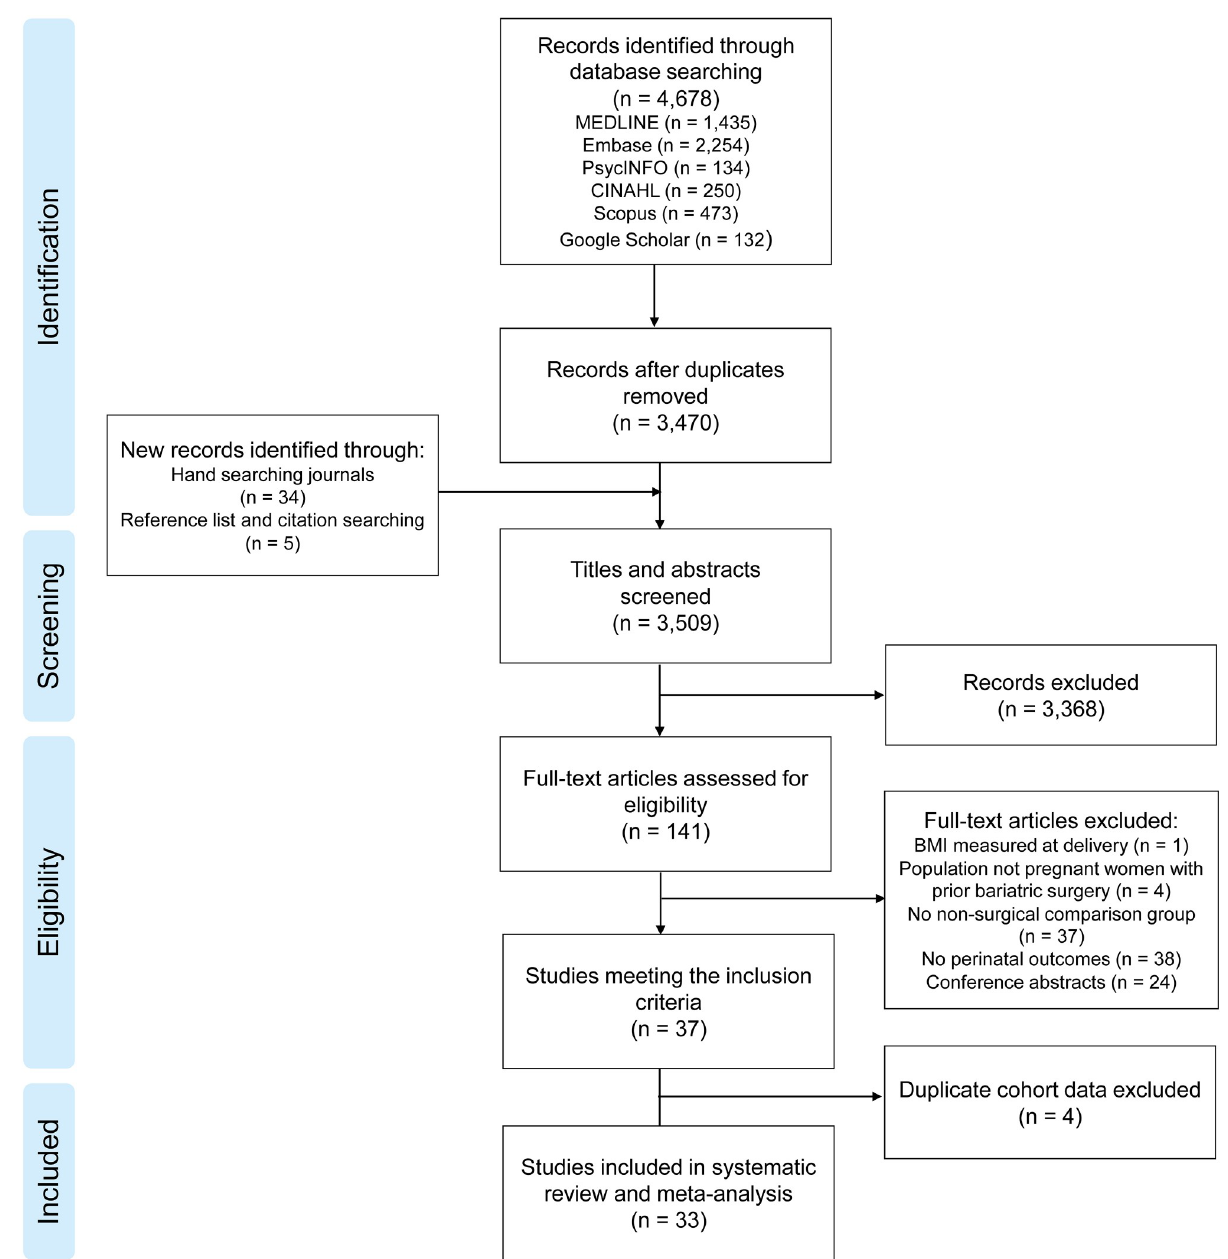
Fig 1. PRISMA flowchart of included studies. BMI, body mass